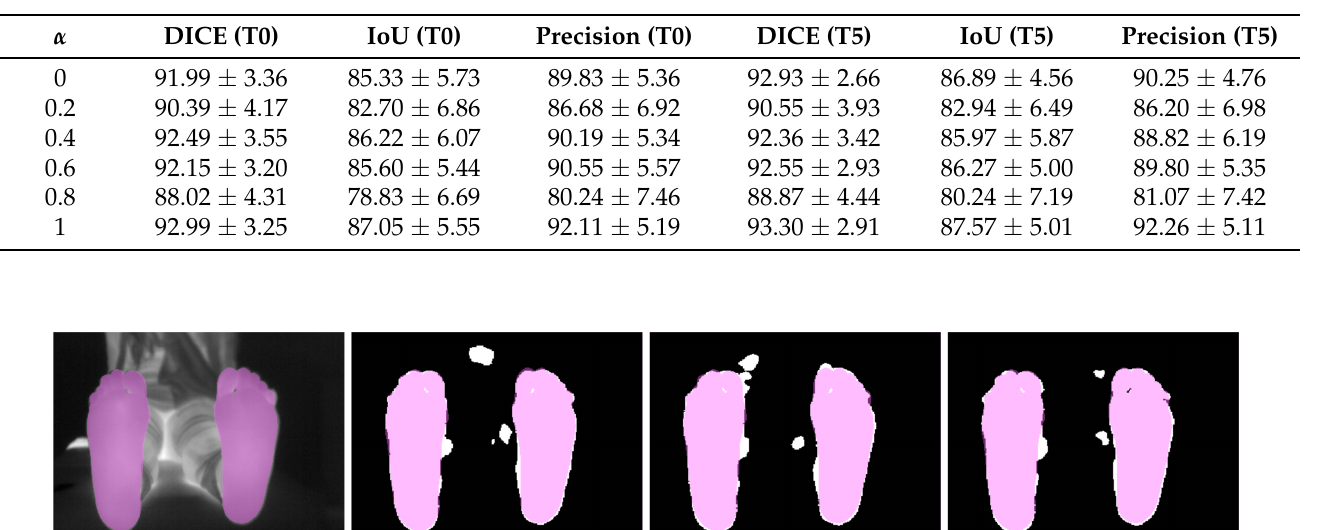
Table 4. DICE , IoU and precision provided by the SegNet approach, according to the α parameter in Equation (1). Values are expressed in percentages at each time point, T0 and T5.